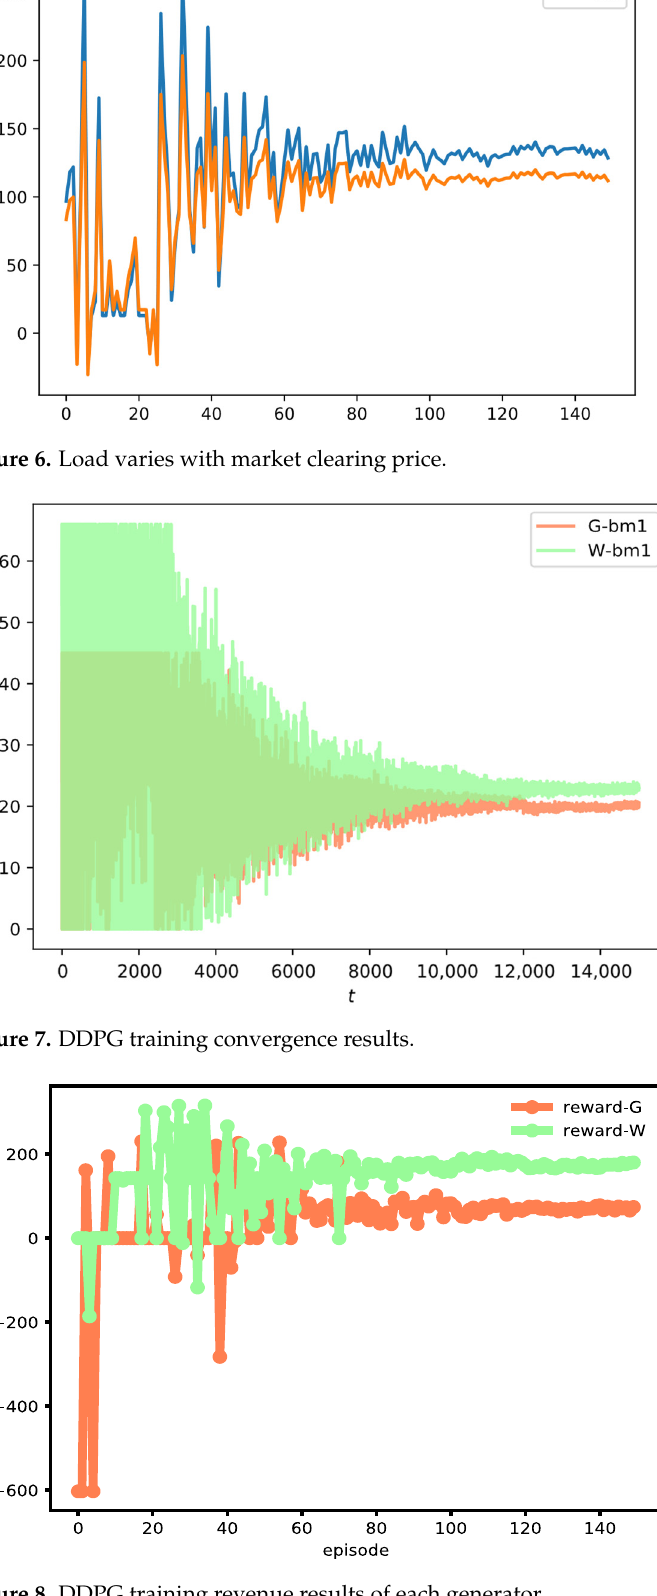
Figure 8. DDPG training revenue results of each generator.